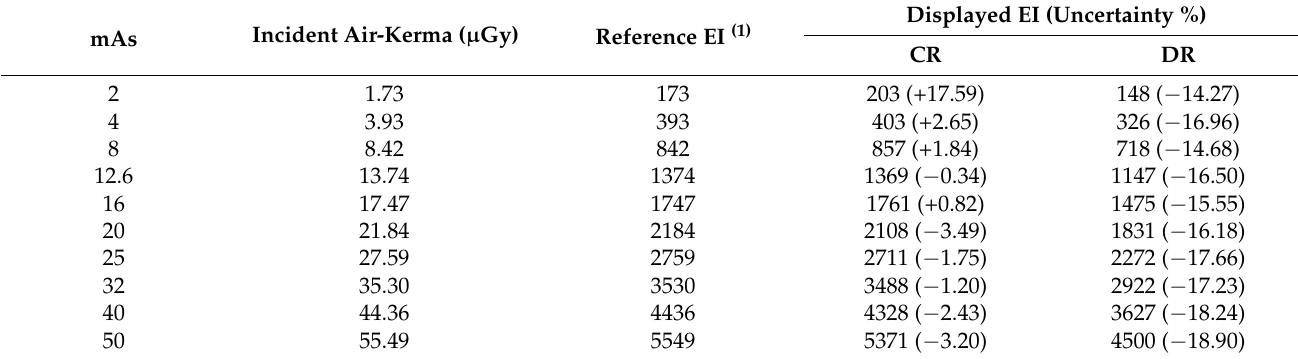
Figure 3. Scheme of experimental geometry in this study. Table 2. Displayed EI and uncertainty from reference EI in